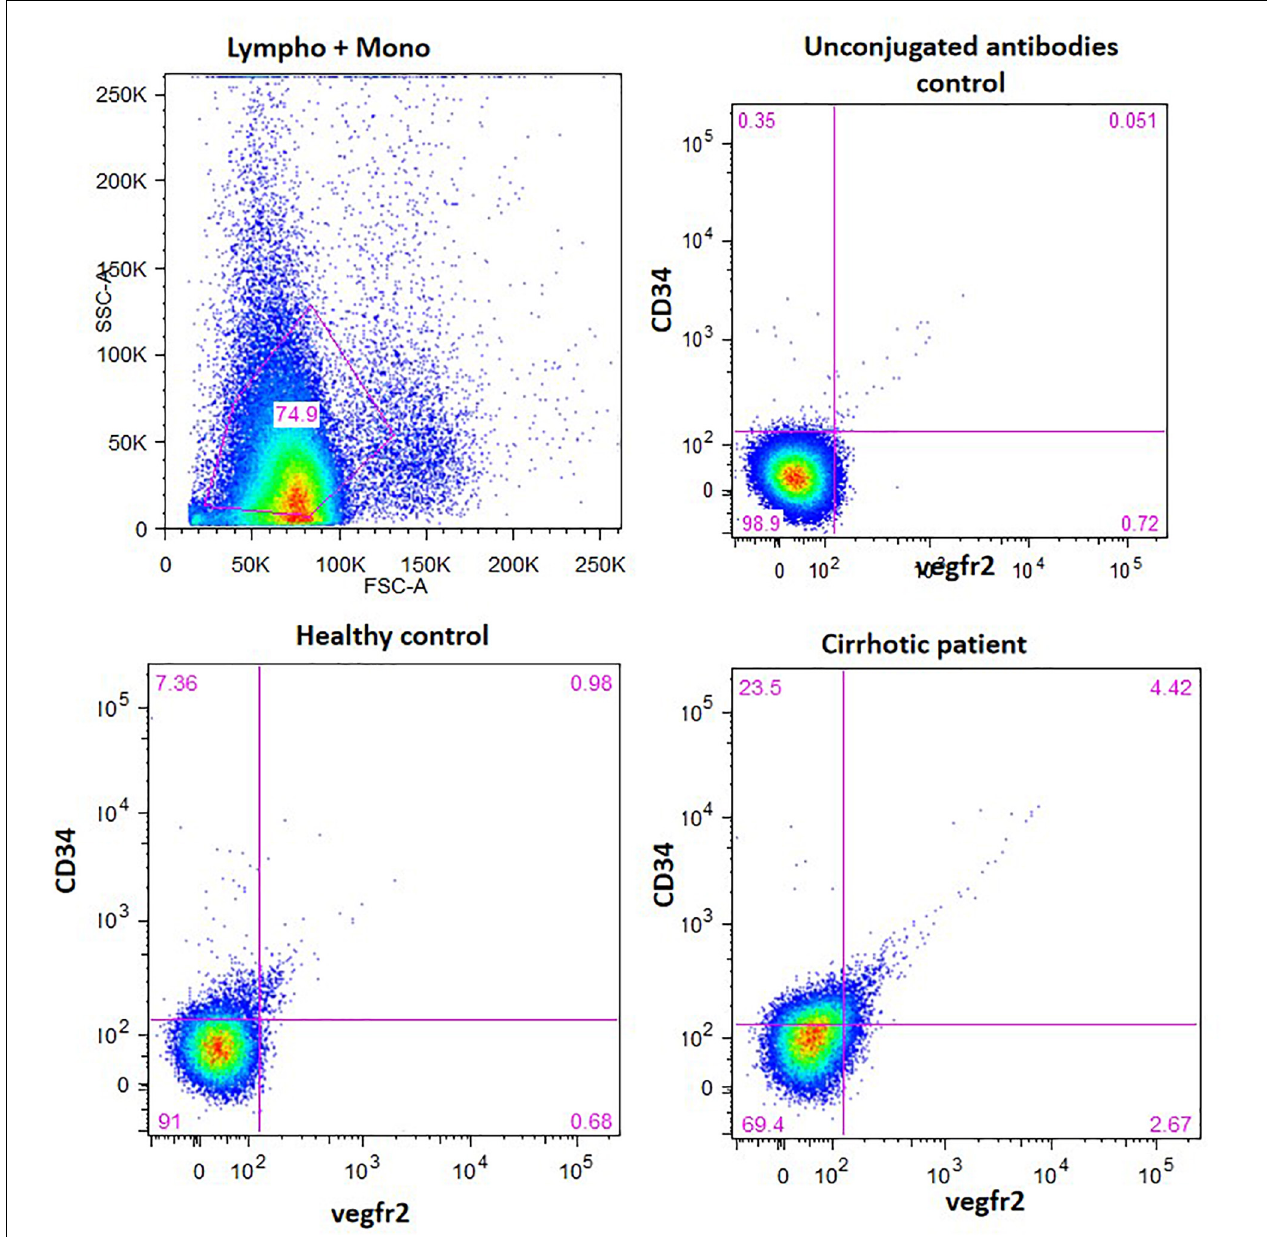
FIGURE 2 | EPC enumeration in whole blood by measuring the percentage of CD34 and vergfr2 dual positive cells in the lymphocyte and monocyte gated cells. The figure shows dot plots of dual stained cells in healthy controls and cirrhotic patients. Unconjugated antibodies without flourophores were used as